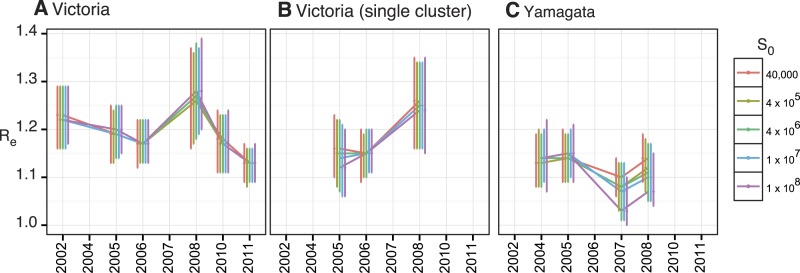
Estimates of Re with
various S0 values.Estimates of effective population size,
Re, using various
S0 values for all Victoria
(A) and Yamagata (C) lineage viruses isolated
in Australia and for the largest monophyletic group of Victoria
(B) viruses in Australia that clearly represent a single
introduction.